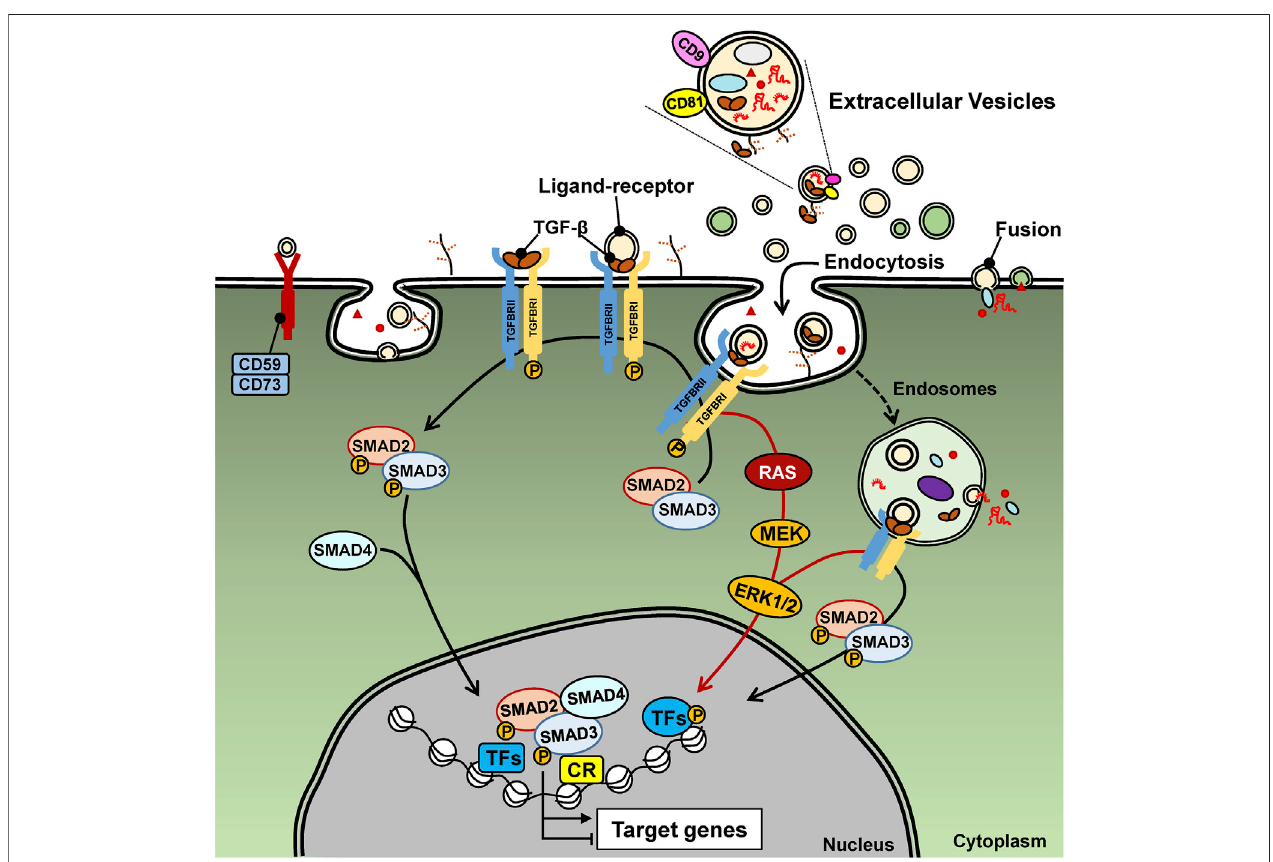
FIGURE 2 | TGF- β signaling. Extracellular TGF- β (usually deposited in the ECM) and here shown as free mature TGF- β , binds to the type II and type I receptors on the cell surface, which signal via inter-receptor trans-phosphorylation. The type I receptor phosphorylates SMAD2 and SMAD3 that results in their oligomerization with SMAD4. The ligand-bound receptors also activate RAS, MEK, ERK and other (not shown) protein kinase signaling pathways. EV-associated TGF- β signals in the same manner, yet the ligand is presented from the surface of EVs, as endocytosis of these EVs is in progress. The signaling proteins, SMADs and MAPKs regulate gene transcription via directbindingtoDNA(SMADs)and via phosphorylationoftranscriptionfactors(TF)andassociationwithchromatinregulatoryprotein(CR).MiRNAsand lncRNAsareillustratedasEVcargoandmay beviewedwithpotentialcautionastotheabilityofEVstodeliverfunctionalRNAstotherecipientcellsthatcanaffectTGF- β signaling either in a positive or negative